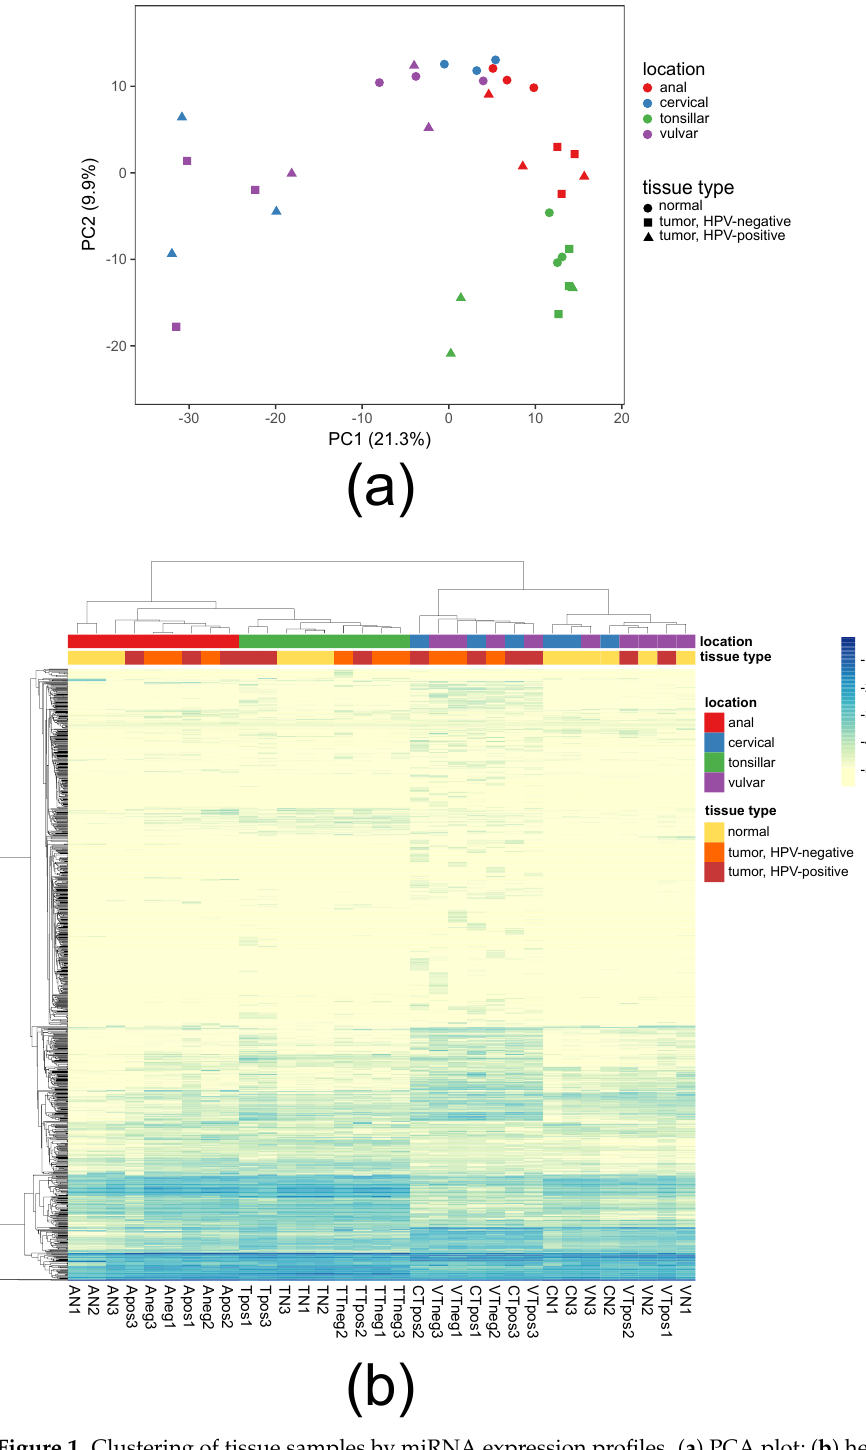
Figure 1. Clustering of tissue samples by miRNA expression profiles. ( a ) PCA plot; ( b ) heatmap plot. The heatmap color scale depicts log-transformed abundance values of individual miRNAs among total miRNA sequencing reads. Visualizations were carried out in ClustVis